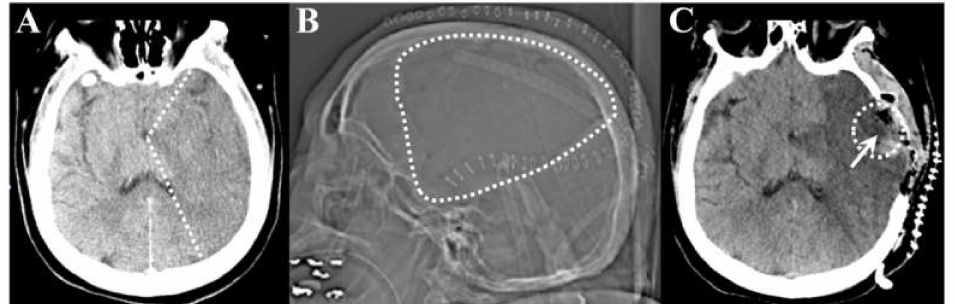
Figure 1. Representative pre-operative and post-operative images from the same stroke patient. ( A ): Axial computed tomography (CT) scan at one day post stroke demonstrating left sided middle cerebral artery infarct with loss of grey-white matter differentiation in a large territory. The white dot- ted line points out the approximate infarct border. ( B ): Post-operative CT scout image demonstrating the large craniotomy defect (dotted line). ( C ): Post-operative axial CT scan demonstrating completed infarct, bony decompression, and the region of partial stroke resection in the temporal lobe